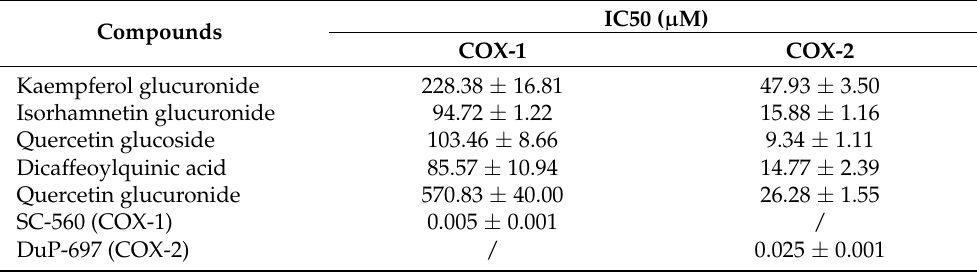
Table 2. Anti-inflammatory potential evaluation of polyphenolic compounds of F. vulgare measured as inhibition of COX-1 and COX-2 enzymes, expressed as the media of three determinations of the IC 50 ( µ M) ± SD (standard deviations). SC-560 and DuP-697 are selective inhibitors of COX-1 and COX-2,